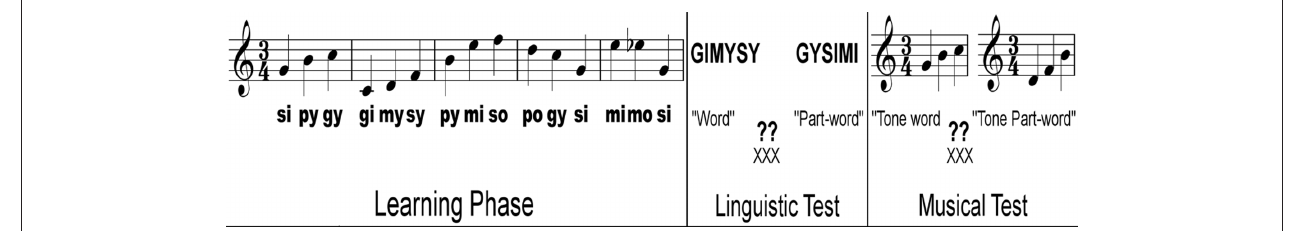
Figure 1 | illustration of the experimental design used in our three experiments: a learning phase is administered to participants and is followed by one (Schön et al., 2008) or two tests (Francois and Schön, 2010, 2011) depending on the experiment. The linguistic test uses spoken items while the musical test uses